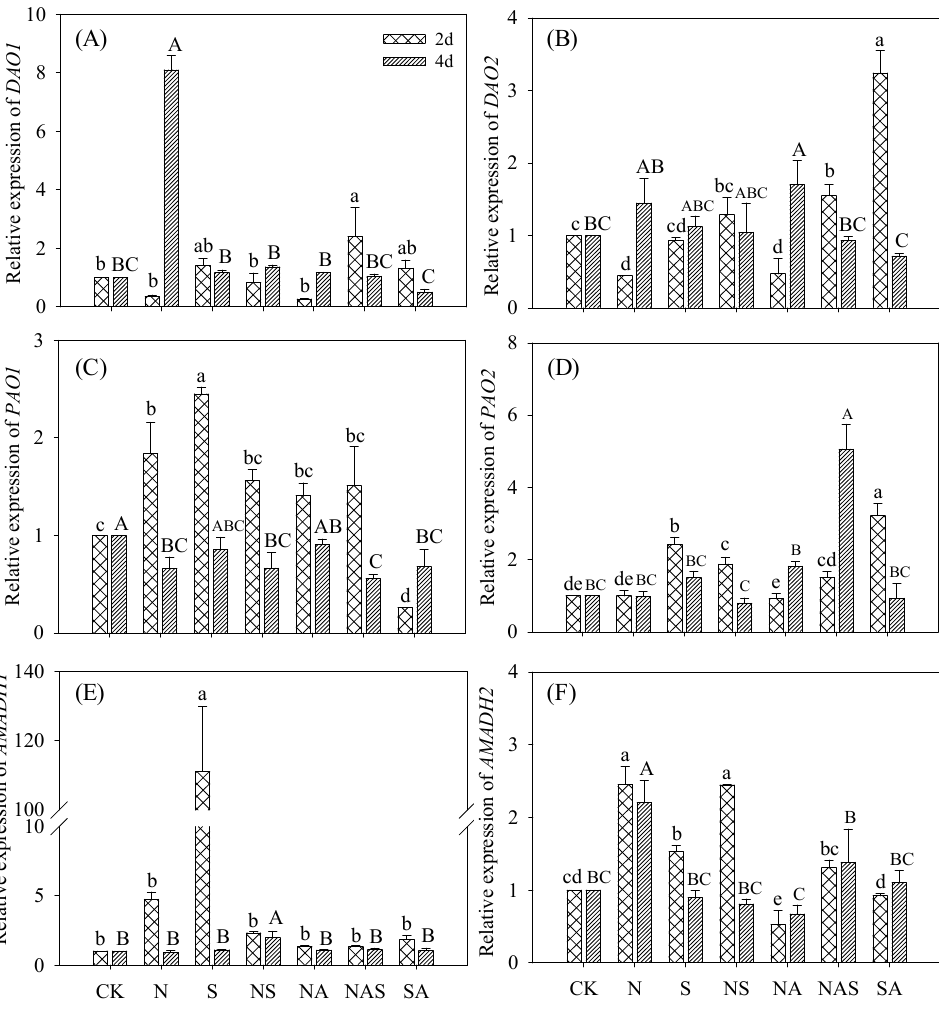
Figure 7. Changes of ( A ) DAO1 , ( B ) DAO2 , ( C ) PAO1 , ( D ) PAO2 , ( E ) AMADH1 , and ( F ) AMADH2 relative expression in germinating soybeans. Lowercase letters reflect the significance of di ff erences in index among treatments of 2-day germinating soybeans and capital letters reflect the significance of di ff erences in index among treatments of 4-day germinating soybeans ( p < 0.05). CK, Control; N, NaCl; S, Spd; NS, NaCl + Spd; NA, NaCl + AG; NAS, NaCl + AG + Spd; SA, Spd + AG; AG,